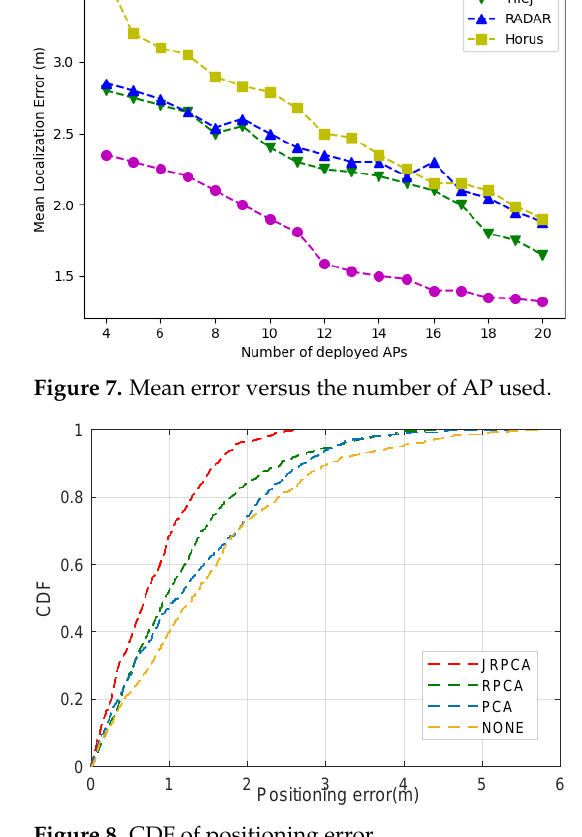
Figure 8. CDF of positioning error.